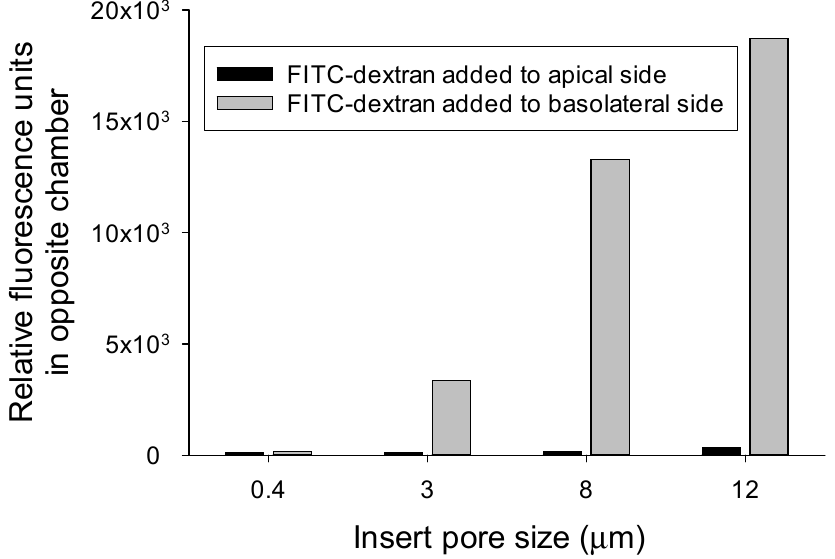
Figure 4. Mouse enterocytes were cultured on inserts with 0.4, 3, 8, and 12 µm pores. The direc- tionality of FITC-dextran movement was evaluated by adding FITC-dextran to either the apical or to the basolateral chamber before starting 5 min of vigorous aeration and measuring fluorescence accumulation in the other chamber. ( n = 6 inserts for each value).